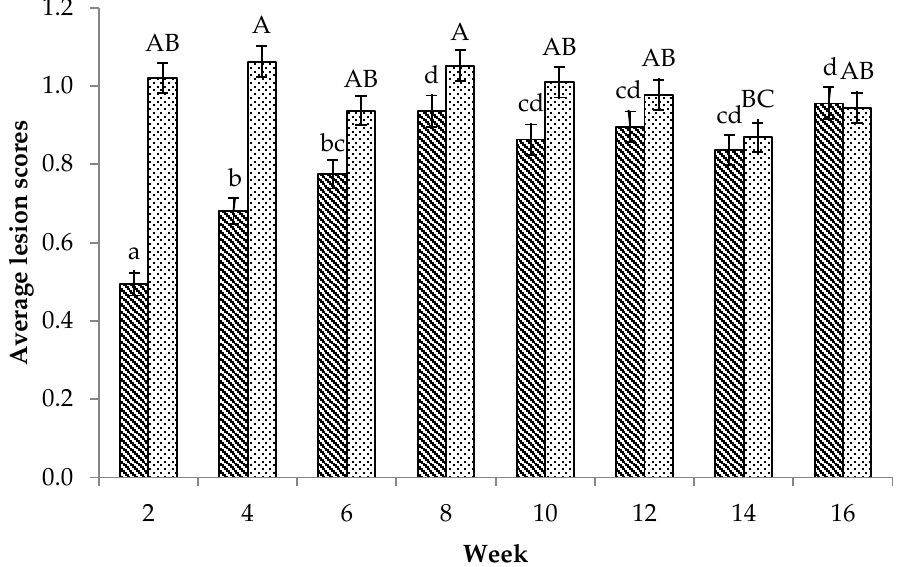
Figure 1. The mean ± S.E. tail and ear lesion scores across time ( n = 48 per treatment group): The tail